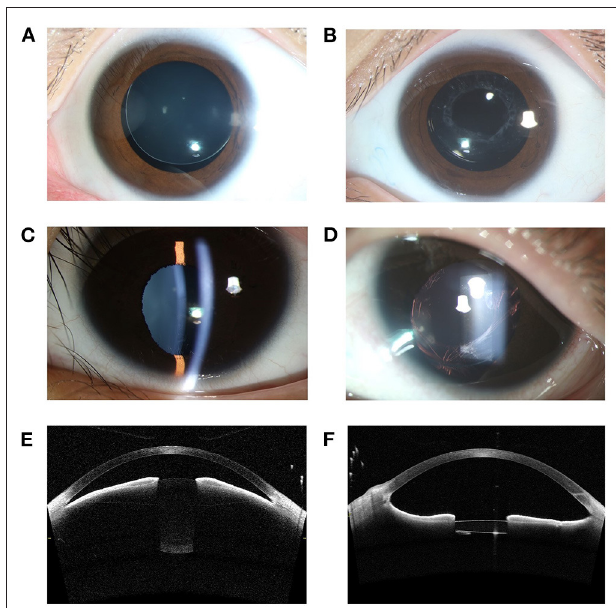
FIGURE 2 | Representative photographic images and AS-OCT images of MSP eyes. (A) A slit-lamp photograph of a MSP eye with Marfan syndrome before surgery revealed a small lens with superior dislocation. (B) The preserved capsule on 1-year follow-up after Nd:YAG laser treatment. This is the same eye as in (A) . (C) One eye of MSP was complicated with ectopia pupillae. (D) The visual axis was clear on 1-year follow-up after the SCSF-IOL procedure and Nd:YAG laser capsulotomy. This is the same eye as in (C) . (E) AS-OCT showed the spherically shaped lens and forward migration of the iris-lens diaphragm in one MSP eye with Marfan syndrome. (F) The narrowing of the anterior chamber angle was significantly relieved 3-month postoperatively. This is the same eye as in (E) . AS-OCT, anterior segment optical coherence tomography; SCSF-IOL, supra-capsular and scleral-fixated intraocular lens implantation; MSP, microspherophakia.